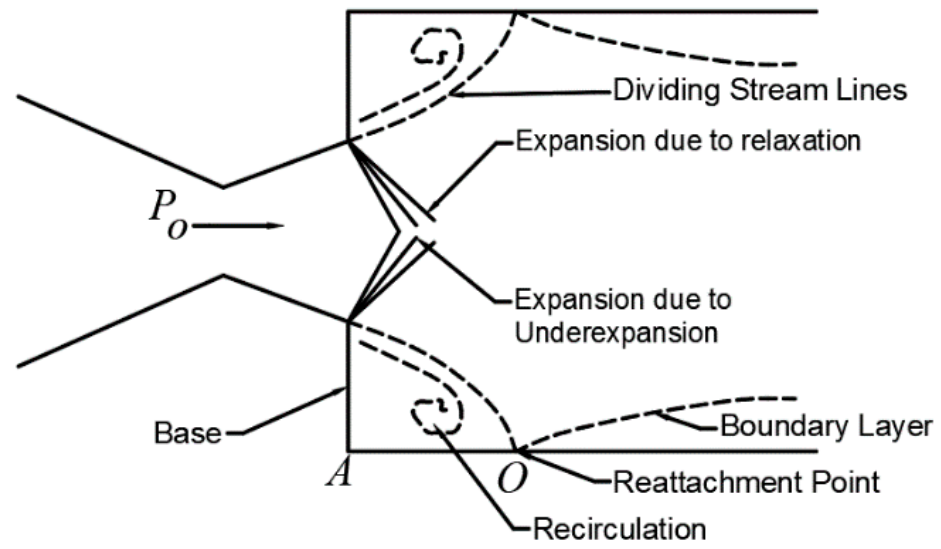
Figure 2. Schematic diagram of over-expanded flow field.